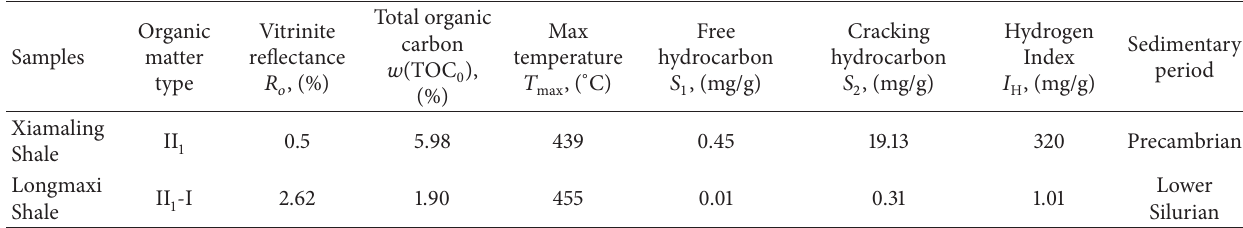
Table 1: Geochemical characteristics of the shale